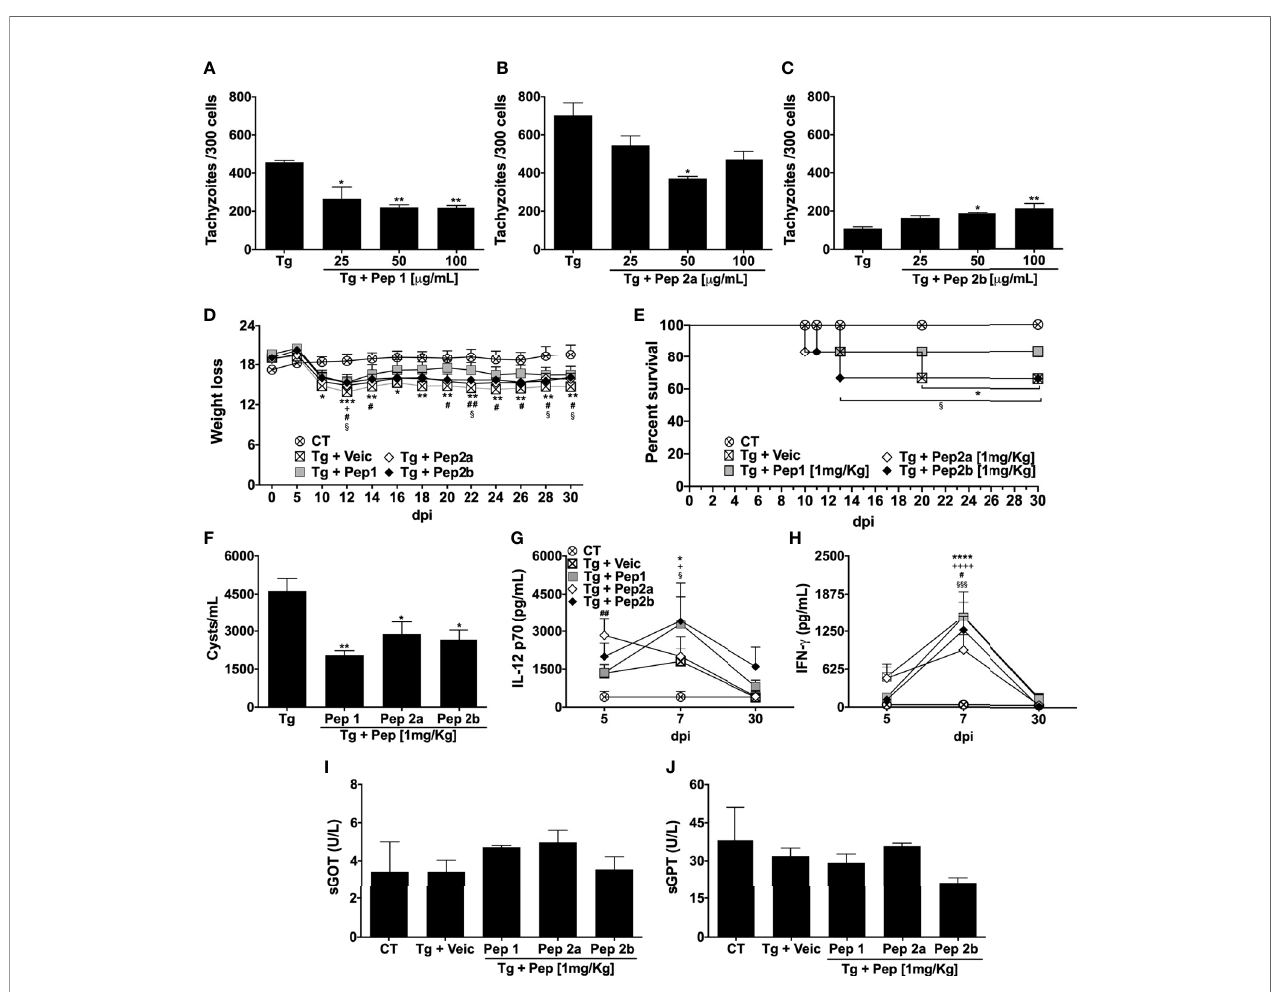
FIGURE 5 | Evaluation of the anti- T. gondii activity of Pep1, Pep2a, and Pep2b peptides in vitro and in vivo . Peritoneal macrophages from C57Bl/6 female mice were cultured and infected (1:1 T. gondii : cell ratio) and/or stimulated by Pep1 (A) , Pep2a (B) , or Pep2b (C) at 25, 50, or 100 µg/mL. Intracellular parasite counts were performed on fi xed and stained cells at 48 h post-infection/stimulus (Each point represents means ± SEM of one of the two independent experiments, * p ≤ 0.05; ** p < 0.01). C57Bl/6 mice (n= 6/group) were infected with 20 cysts of T. gondii (ME49 strain) and treated or not with Pep1, Pep2a, or Pep2b (1 mg/kg) at 8 h after infection until the 7 th day post infection (dpi). The weight loss (D) and survival (E) were monitored from the 5 th – 30 th dpi. The cytokines IL-12p70 (G) and IFN- g (H) were quanti fi ed in the serum of the animals on 5 th , 7 th , and 30 th dpi. The mice were euthanized on 30 th dpi for the brain cyst count (F) and measurement of liver enzymes in the serum [sGOT (I) and sGPT (J) ]. “ CT ” = control (non-infected mice). “ Tg + Veic ” = infected-mice vehicle-injected ➔ * p ≤ 0.05; ** p< 0.01; *** p < 0.001; **** p < 0.0001 (CT x Tg + Veic) ! + p ≤ 0.05; +++ p < 0.001; ++++ p < 0.0001 (CT x Tg + Pep1) ! # p ≤ 0.05; ## p < 0.01 (CT x Tg + Pep2a) ! § p ≤ 0.05; §§§ p < 0.001 (CT x Tg + Pep2b). Each point represents means ± SEM of two independent